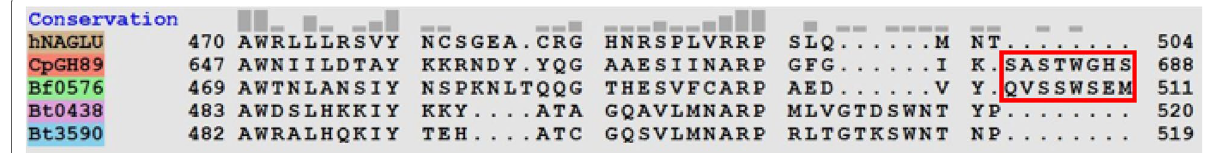
Fig. 2 A segment of structure‑based protein sequence alignment of α‑ N ‑acetylglucosaminidases including hNAGLU (GenBank accession no. AAB06188.1), CpGH89 (GenBank accession no. ABG84150.1), Bf0576 (GenBank accession no. CAH06355.1), Bt0438 (GenBank Accession No. AAO75545.1), and Bt3590 (GenBank Accession No. AAO78695.1). The Trp685‑containing extra loop in CpGH89 structure and the corresponding predicted loop in Bf0576 structural model are shown in the red square